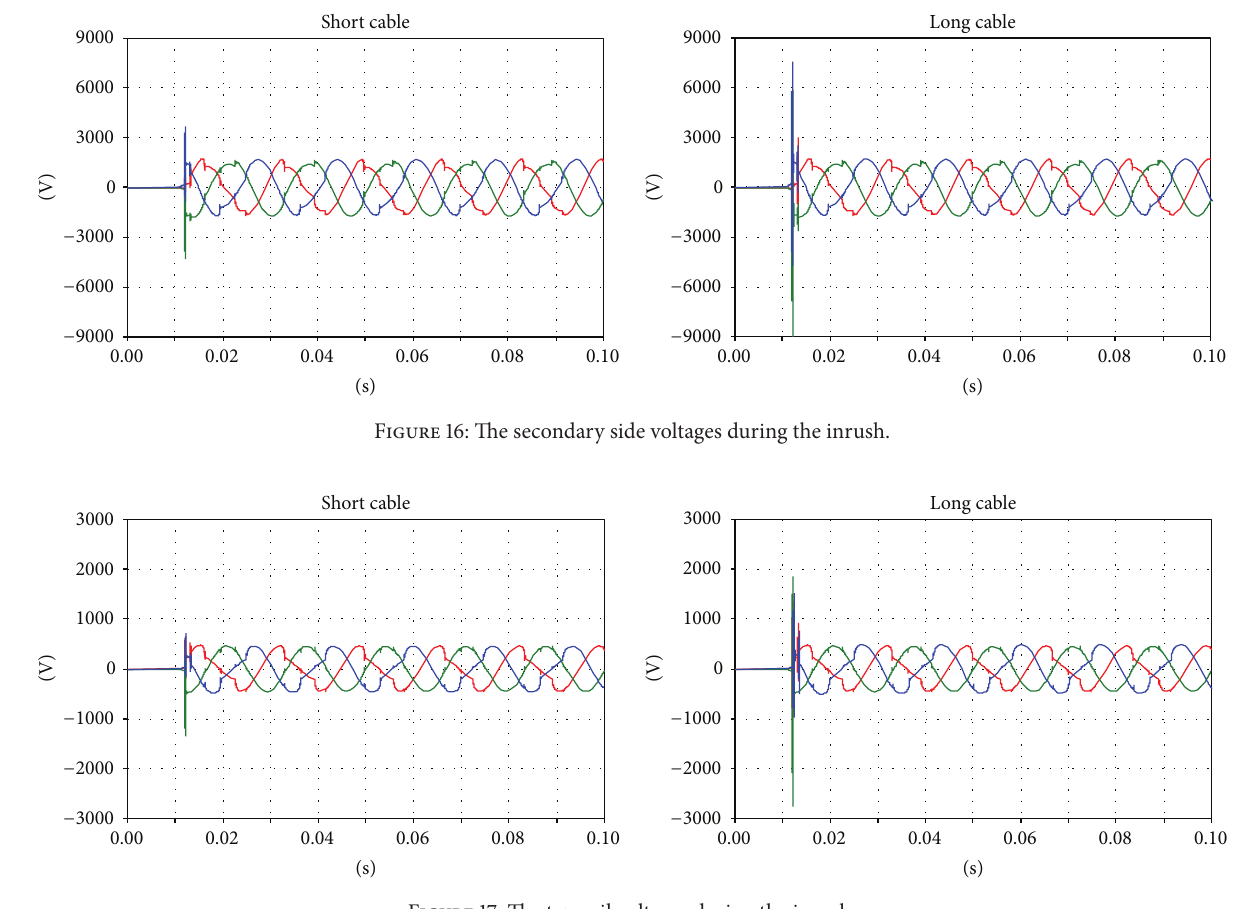
Figure 17: The tap coil voltages during the